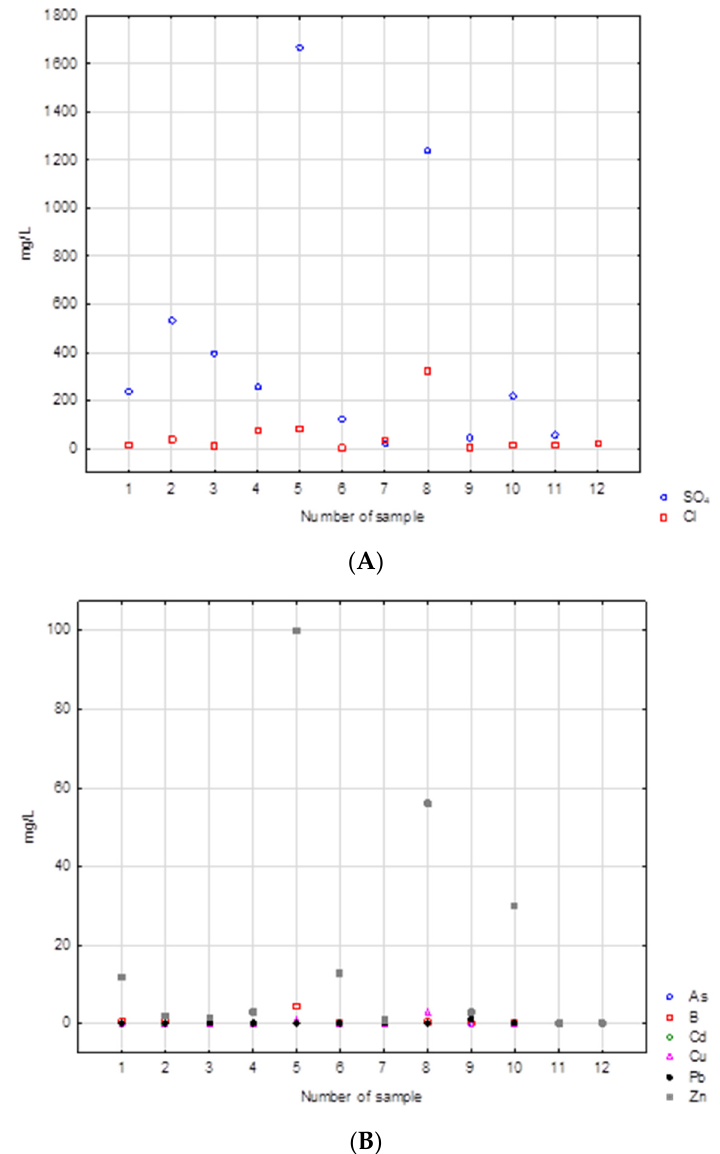
Figure 7. ( A , B ) Concentrations of main ions in the leachates analyzed .